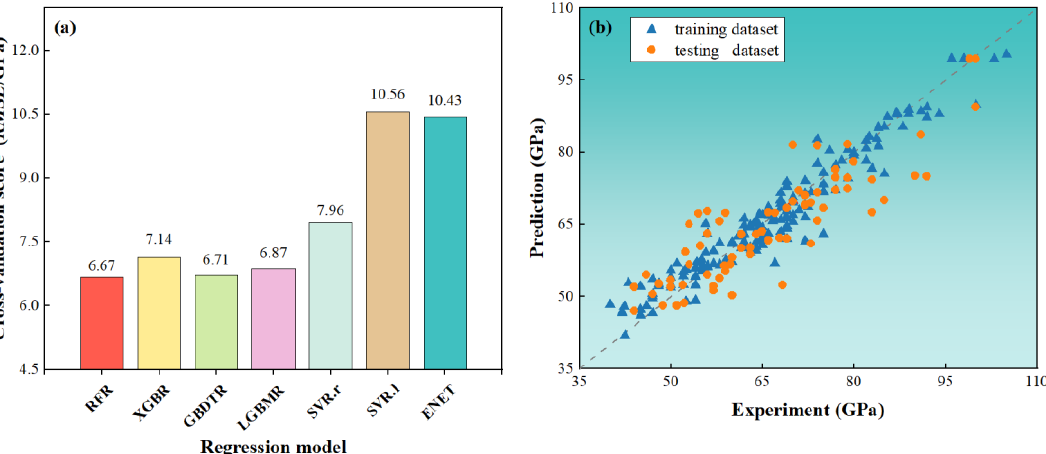
Figure 5. Evaluation of the regression model’s performances: ( a ) cross-validation results under different regression models and ( b ) RFR model prediction on the training dataset and testing dataset.